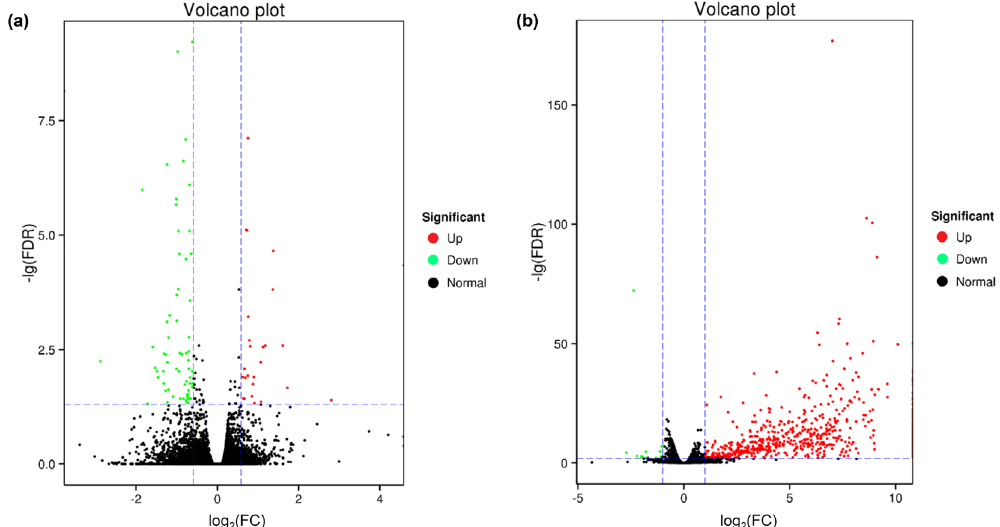
Figure 2. Volcano plots of differentially expressed genes (DEGs) between the nematode-free wheat roots and those exposed to Heterodera avenae juveniles ( a ), and wheat root-free H. avenae juveniles and those exposed to wheat roots ( b ). Each dot represents one gene with the y-axis showing -lg (FDR) and the x-axis showing log 2 (FC), respectively. The red, green and normal dots represent the up-regulated DEGs, down-regulated DEGs (FDR < 0.05 and FC ≥ 1.5 for wheat; FDR < 0.01 and FC ≥ 2 for nematode) and not significantly changed genes, respectively. FC: fold change; FDR: false discovery